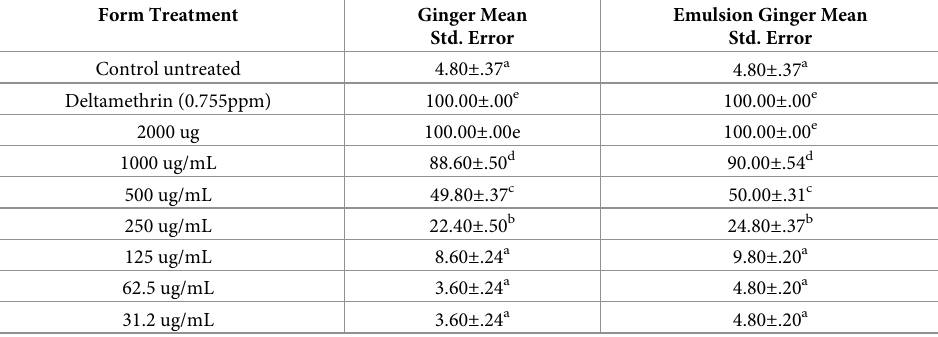
Superscript of the same letter in cells of the same column shows a non-significant effect in respect to the non-treated control. Superscript of different letters in cells of the same column shows a significant effect in respect to the non- treated control ( P � 0.05).